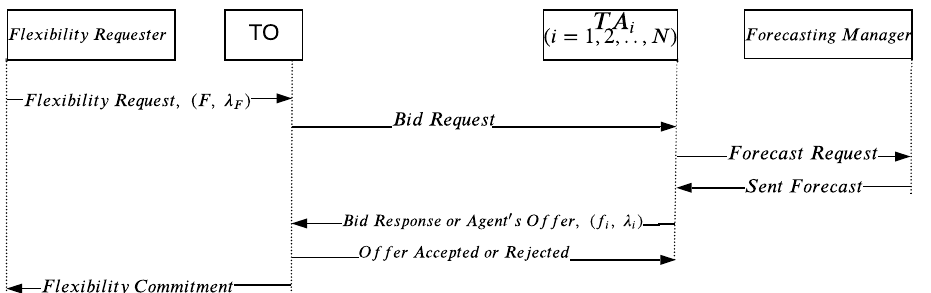
Figure 2. Sequence of communication flow of the flexibility market in the Monash